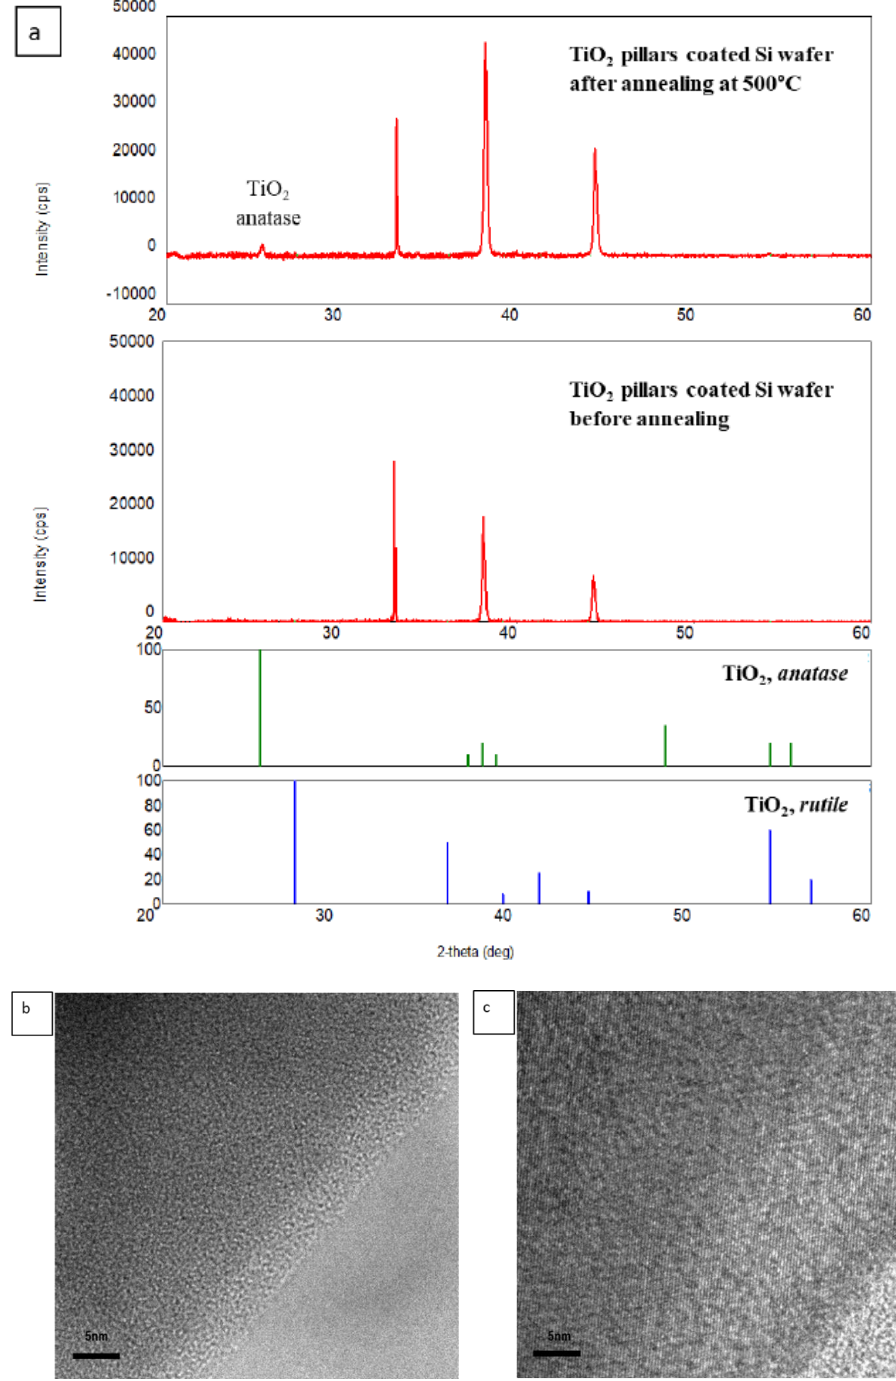
Figure 3. ( a ) XRD analysis of TiO 2 pillar coated Si post array before and after annealing at 500 ◦ C. The blue and green line spectra in the bottom portion of the figure are the reference spectra for anatase and rutile phase TiO 2 , respectively; ( b , c ) high-resolution transmission electron microscopy (HRTEM) analysis before annealing and after annealing at 500 ◦ C, respectively, showing the amorphous phase ( b ) and crystalline phase ( c